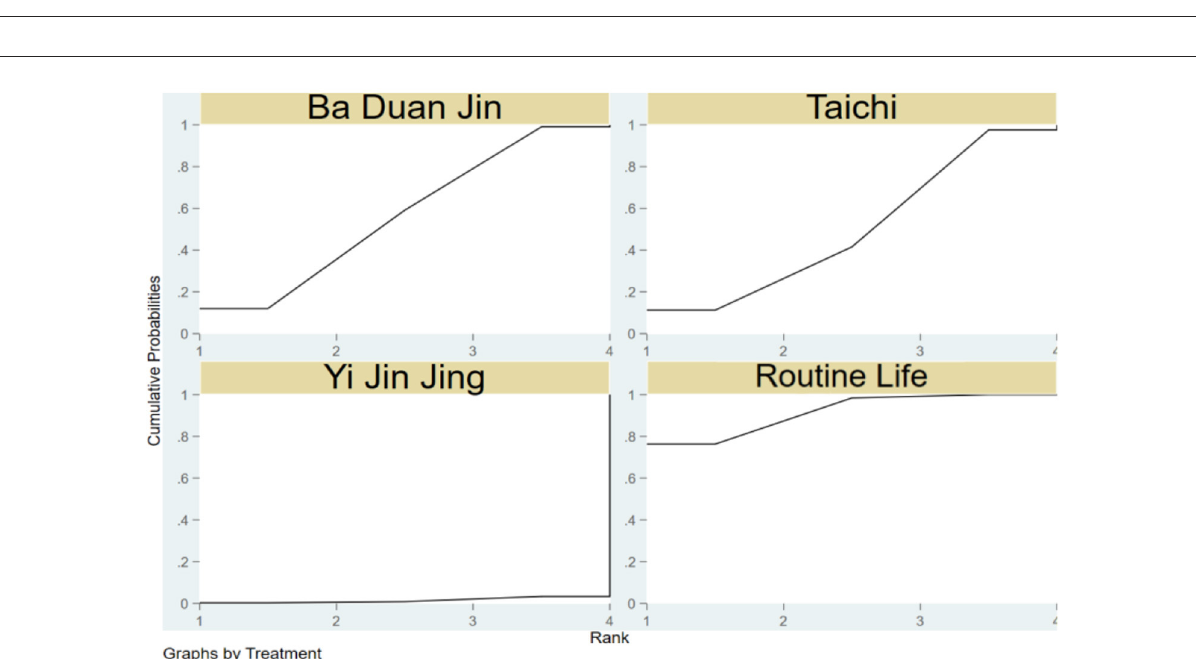
FIGURE10 Cumulative probability SUCRA plots of the effects of different traditional programs on MFES in older